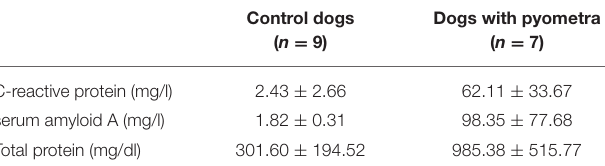
TABLE 2 | The concentration of acute phase proteins in control dogs and dogs with pyometra (mean ± standard deviation).